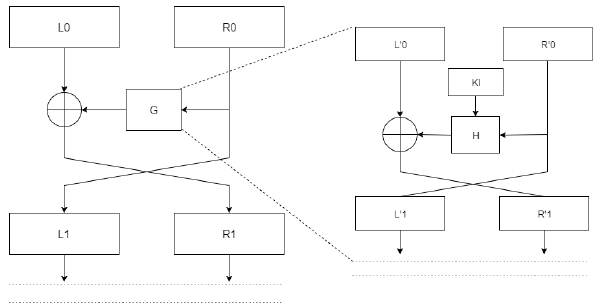
Figure 1: The scheme of the application of the nested Feistel net-